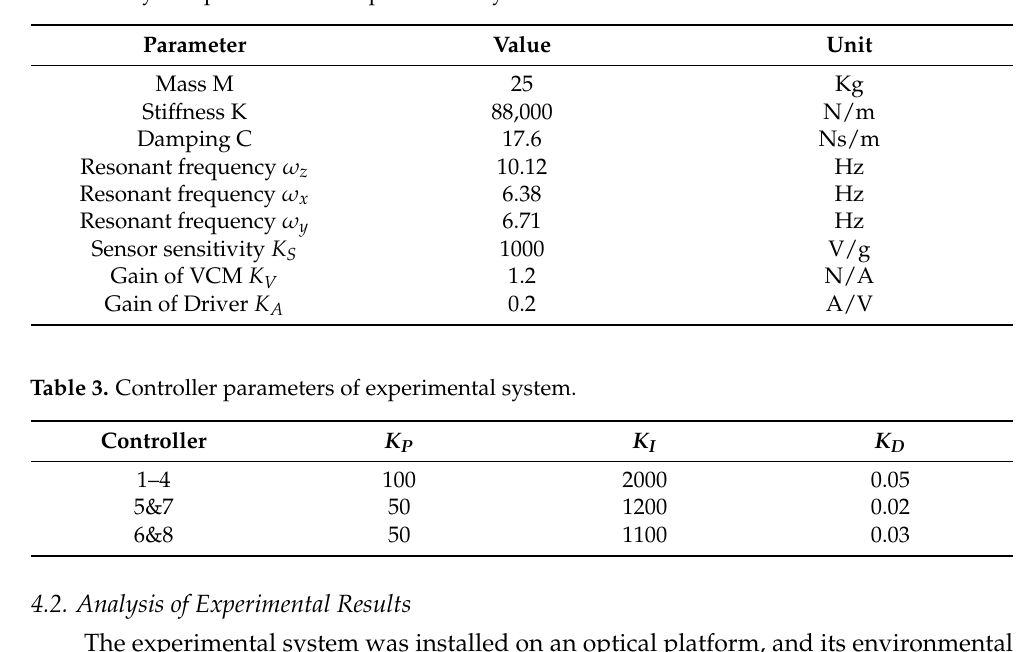
Figure 8. Schematic diagram of experimental system. Table 2. Physical parameters of experimental system.